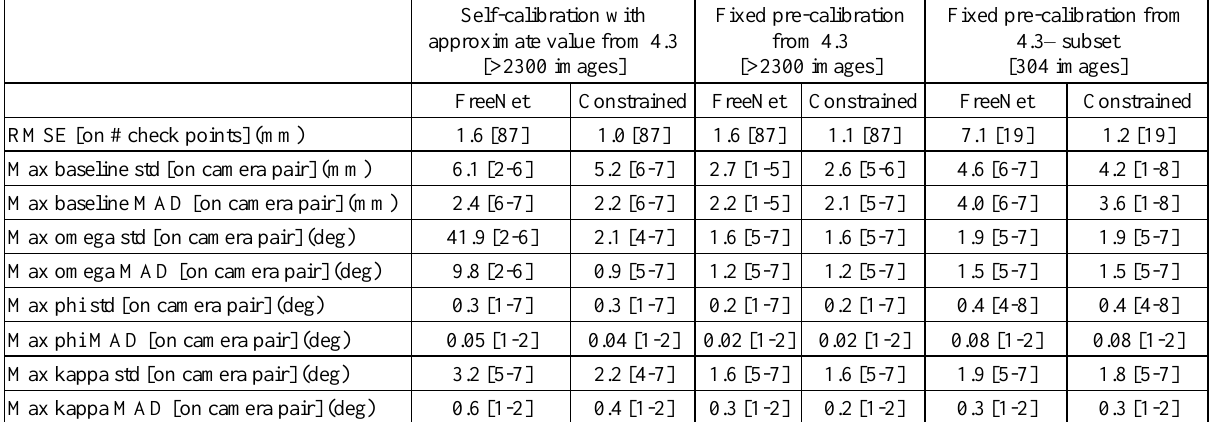
Table 3. Results of multi-camera system